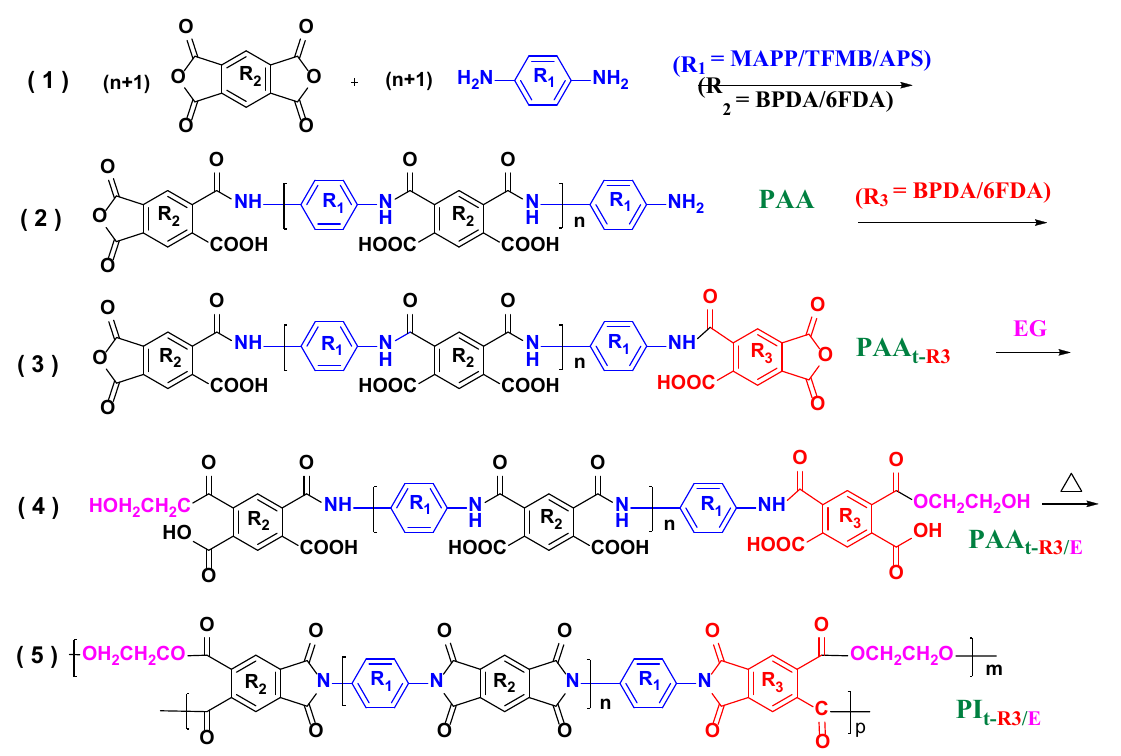
Scheme 2. Monomer structures and highly transparent polyimide synthesis by two-step poly (amic